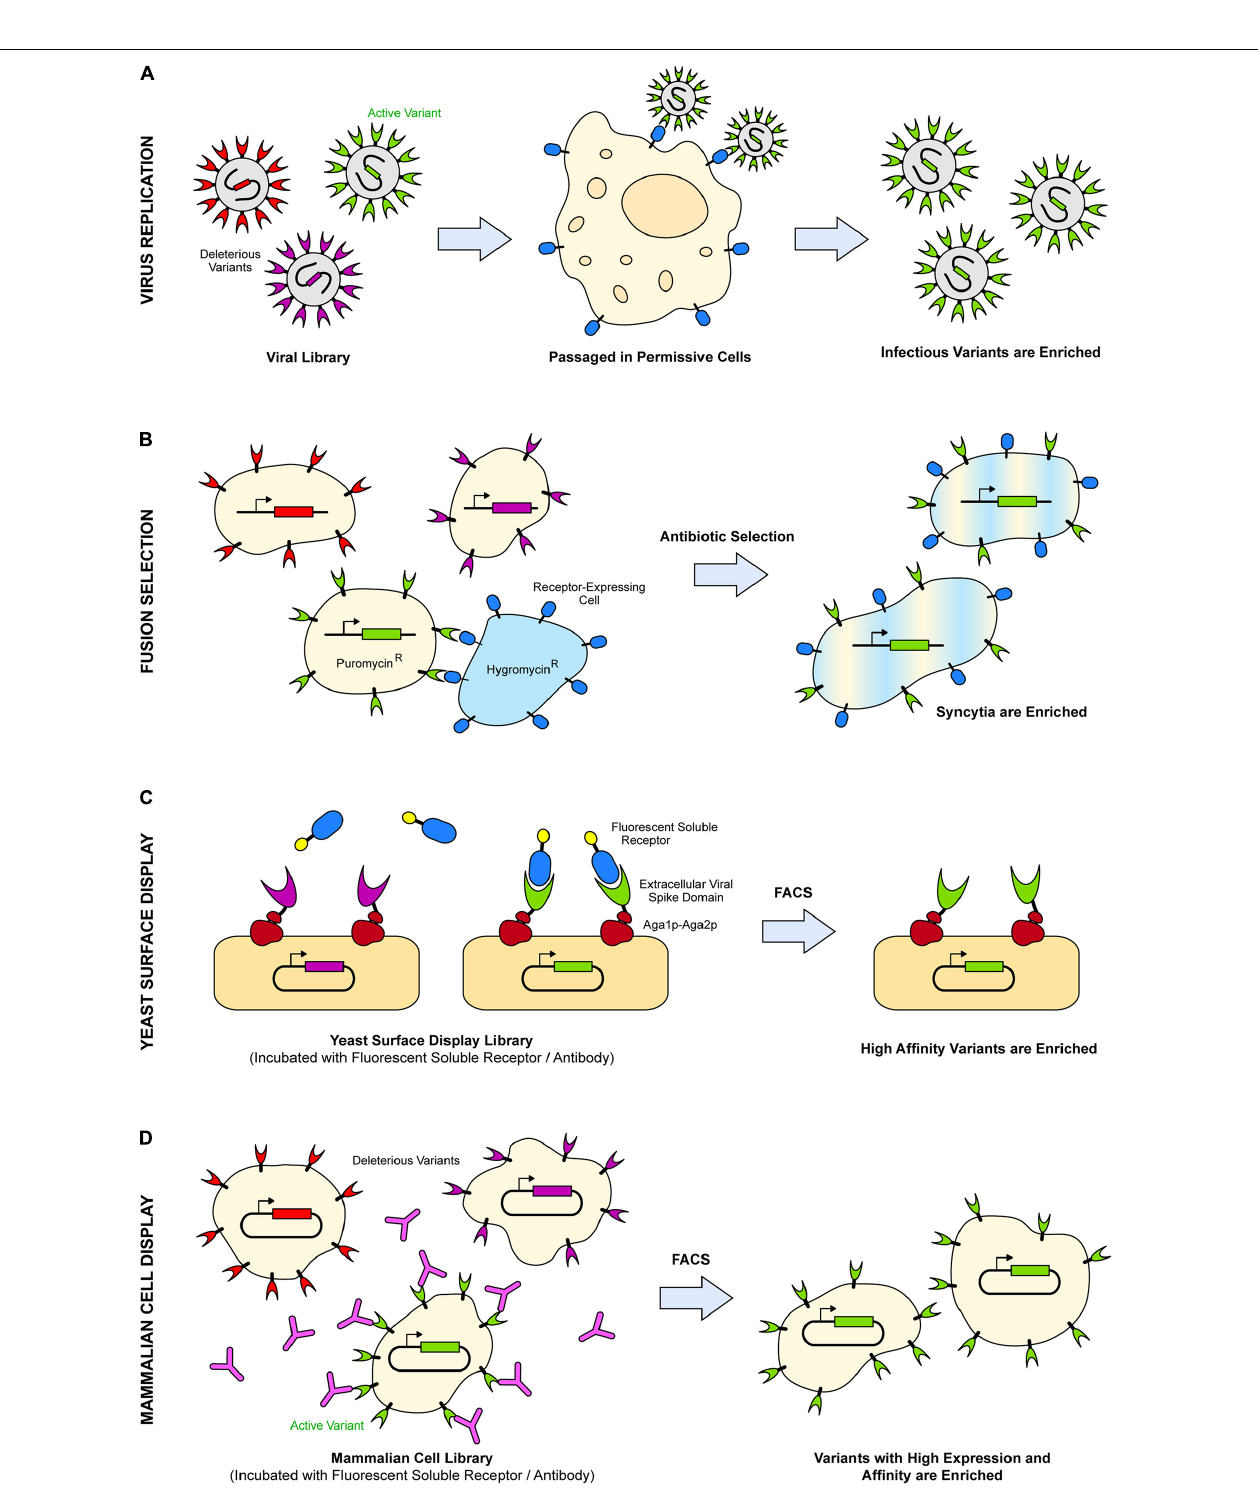
FIGURE 1 | Examples of selection strategies used in deep mutational scans of viral spike proteins. (A) Infectious virus variants (green) are enriched after passaging through a permissive cell line expressing host target receptors (blue). (B) Syncytia are enriched upon fusion of cells expressing variants of viral fusion protein (pale yellow cells) and cells expressing the entry receptor (pale blue cells) in the presence of two different antibiotics. (C) Soluble extracellular domains of the viral spike are displayed on the yeast cell wall via Aga1p–Aga2p (dark red). After fluorescence activated cell sorting (FACS), these viral proteins (green) are enriched if they possess high binding affinity and/or expression to fluorescent partners, such as soluble receptors (blue). (D) After FACS, mammalian cells expressing viral spike proteins (green) are enriched if they are highly expressed and bind with high affinity to fluorescently labeled antibodies (pink) or soluble receptors.